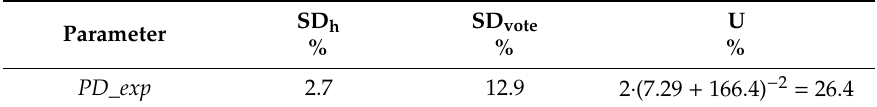
Table 4. Overall uncertainty (U) of experimental indoor perception evaluation (PD_exp = f(h)) based on enthalpy determination uncertainties (SD h ) and vote results (SD vote